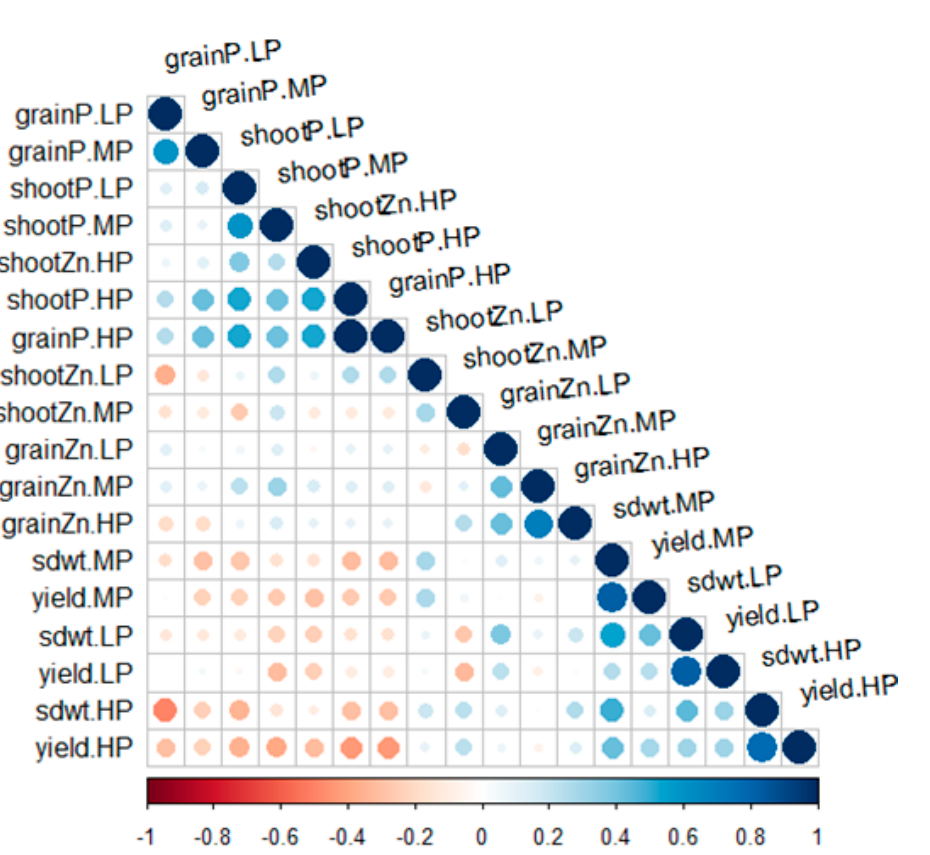
Figure 5. Correlation matrices for traits measured across varying soil phosphorus levels in the field (n = 30 genotypes). Positive and negative associations between given traits are in blue and red, respectively. The color intensity and the size of the circle are proportional to the correlation coefficients. On the X -axis of the correlogram, the legend color shows the correlation coefficients and the corresponding colors. LP = no P 2 O 5 application, MP = 10 kg P 2 O 5 P ha − 1 , and High P = 60 kg P 2 O 5 ha − 1 for P field evaluation. See Table 1 for list and abbreviations of the